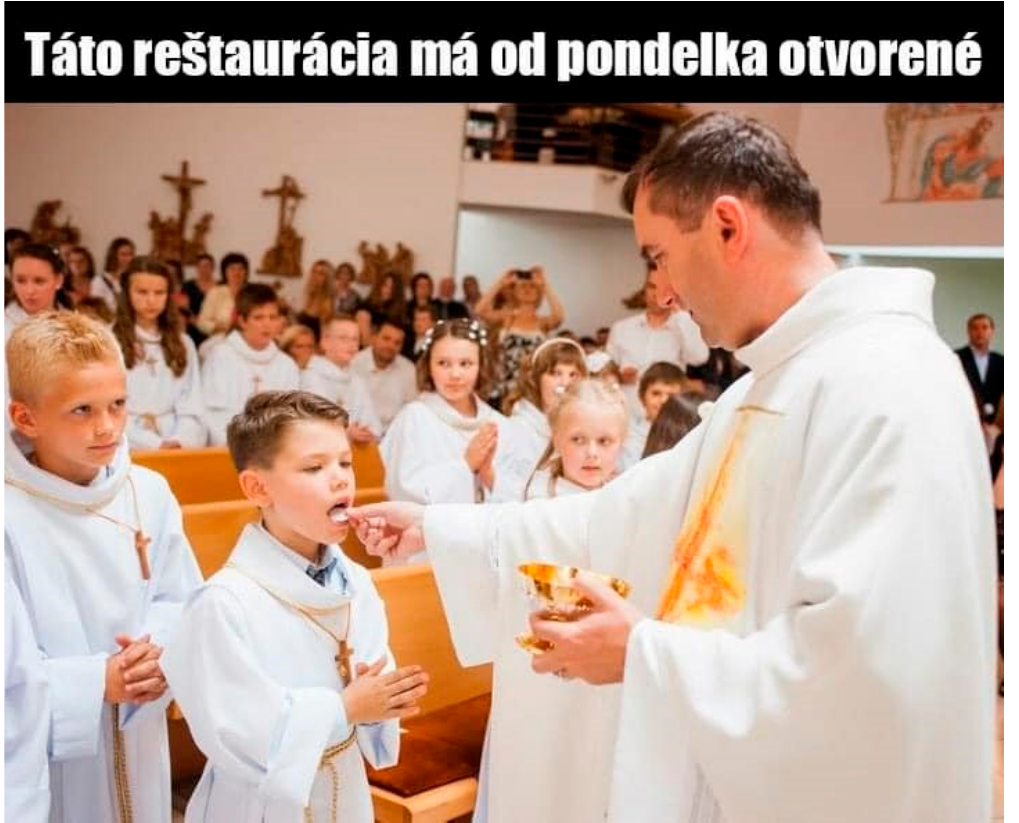
Figure 7. Illustration photo titled ‘This restaurant will open on Monday’ (14 November 2020). This image was published on the Facebook profile of the Slovak MP Jana Bittó Cigániková, member of the liberal party Sloboda a solidarita (Freedom and Solidarity); after becoming viral, the photo was appropriated by a number of media.